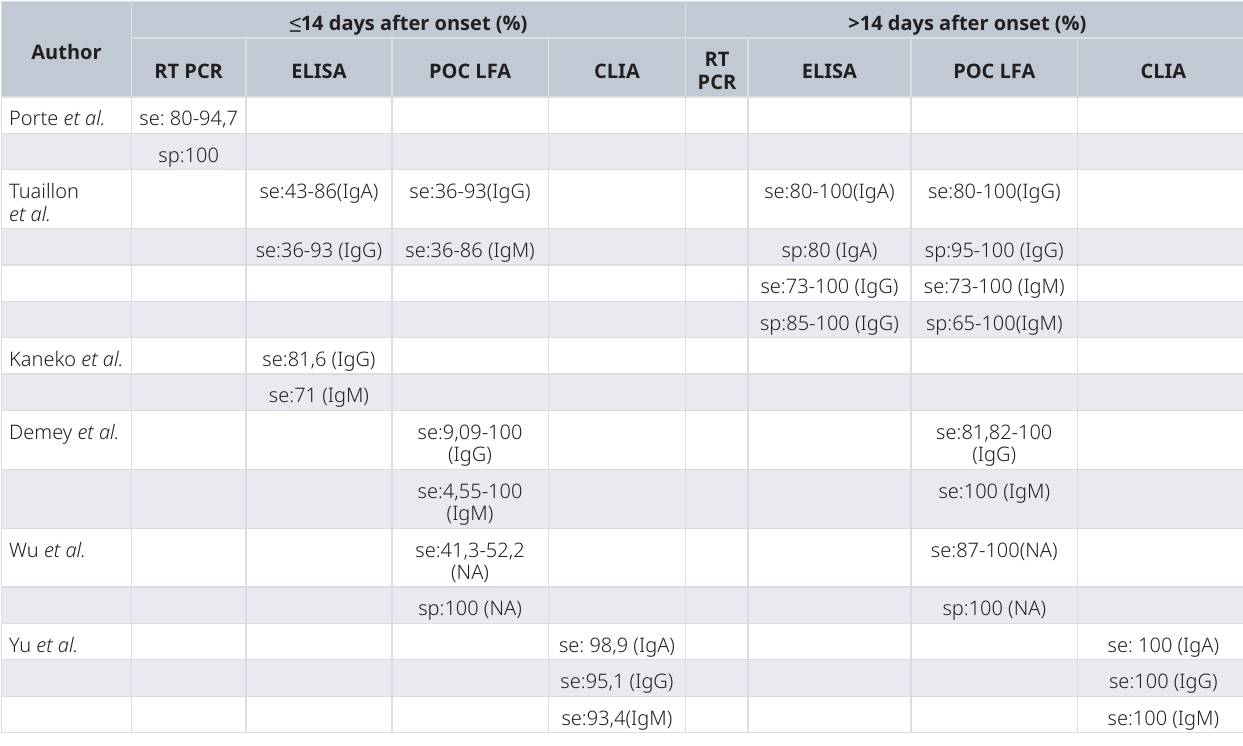
Table 5a. Sensitivity and specificity of diagnostic tests used in the reviewed articles.